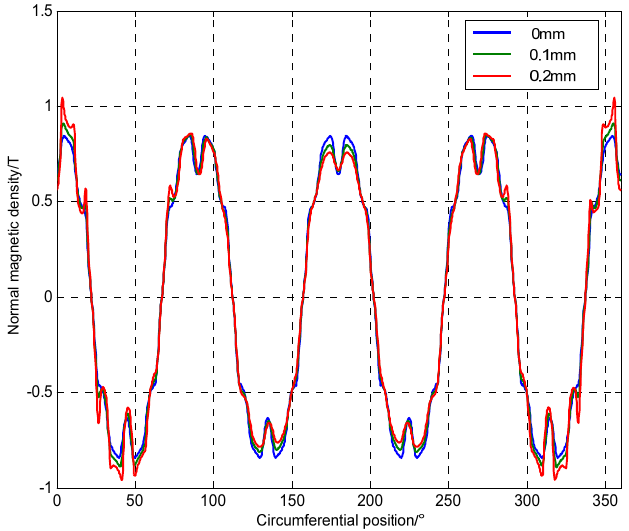
Figure 8. Comparison of normal magnetic density waveforms of air gap in the whole circumference.